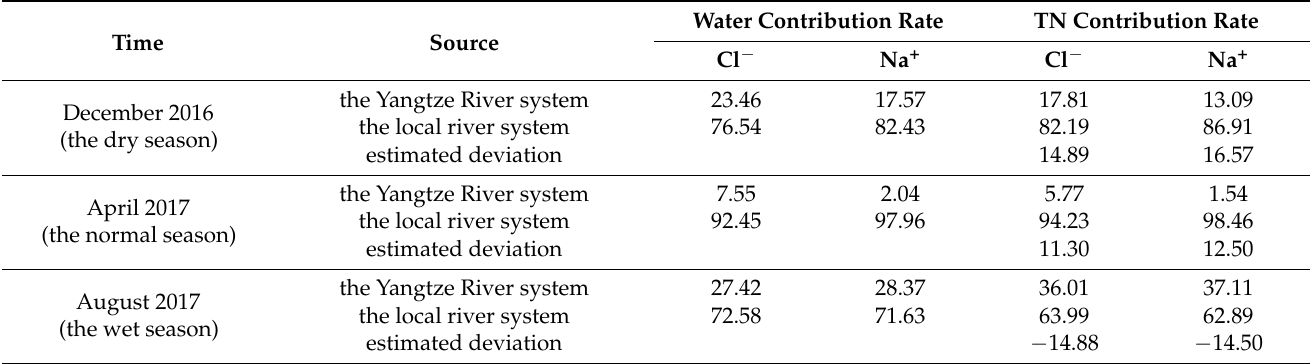
Table 4. Contribution rates of water and TN from the local river system and from the Yangtze River system to West Dongting Lake,